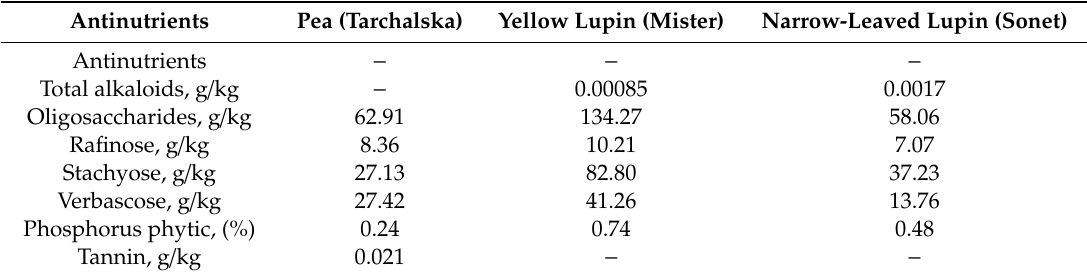
Table 4. Antinutrients in legume seeds used in feed for laying